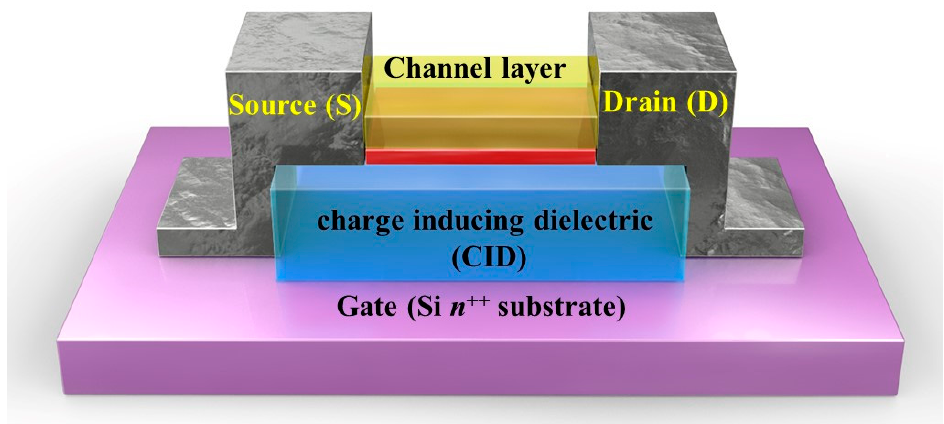
Figure 1. Schematic of a three-terminal device with a metal semiconductor transition (MST) operating principle. The device comprised a gate, source/drain electrodes, TiO 2 channel layer, and charge-inducing dielectric (CID).